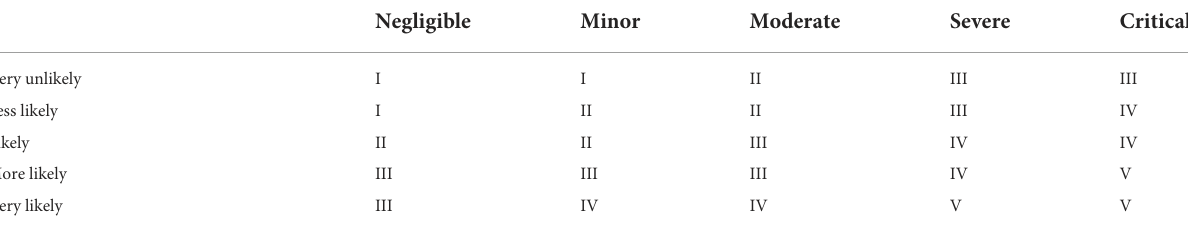
TABLE 1 Risk rating